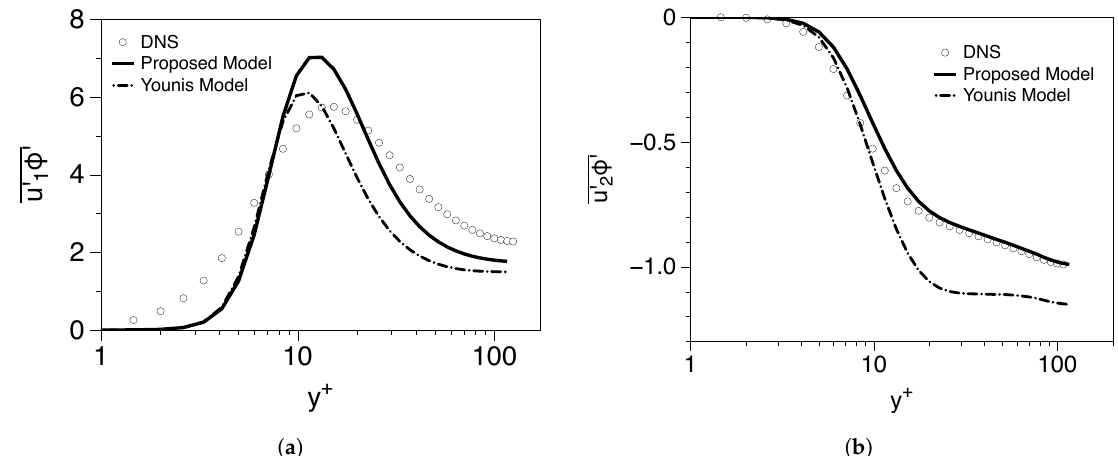
Figure 6. Model predictions for the ( a ) streamwise and ( b ) normal scalar-flux components for a Couette flow at Re w =